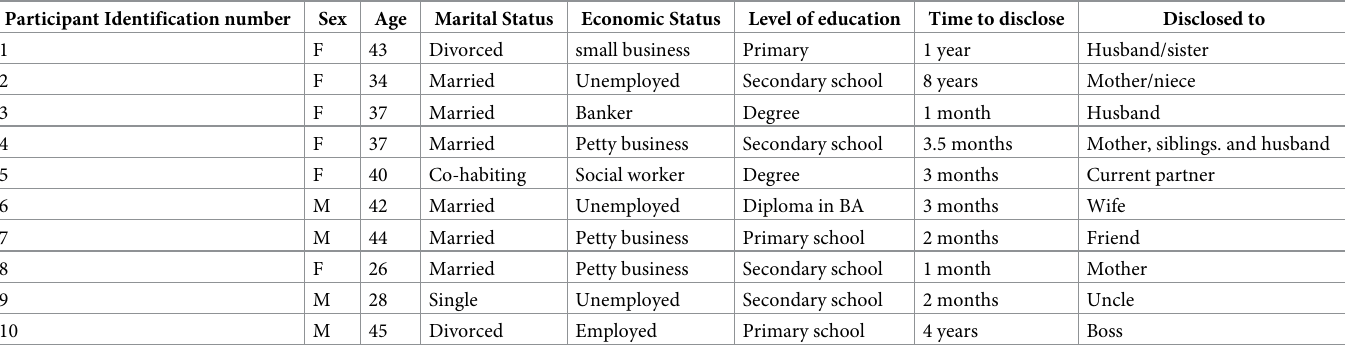
Table 2. Participants’ demographics and disclosure